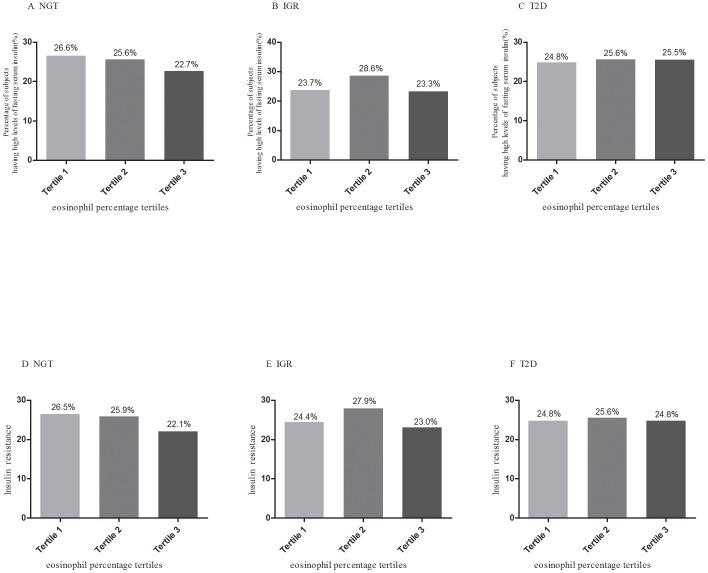
Percentages of elevated fasting serum insulin and insulin resistance across tertiles of eosinophil percentage among NGT, IGR and T2D.(A): Elevated fasting serum insulin in NGT; (B): Elevated fasting serum insulin in IGR; (C): Elevated fasting serum insulin in T2D; (D): Insulin resistance in NGT; (E): Insulin resistance in IGR; (F): Insulin resistance T2D. Number above every bar showed the percentages of the subjects having elevated levels of fasting serum insulin and insulin resistance.